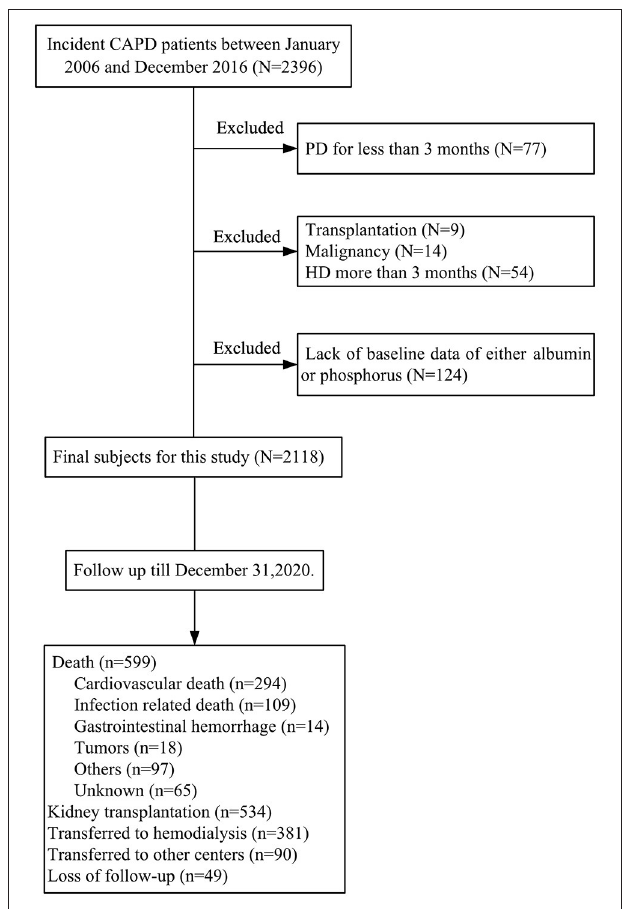
FIGURE 1 | Subjects’ inclusion flowchart.